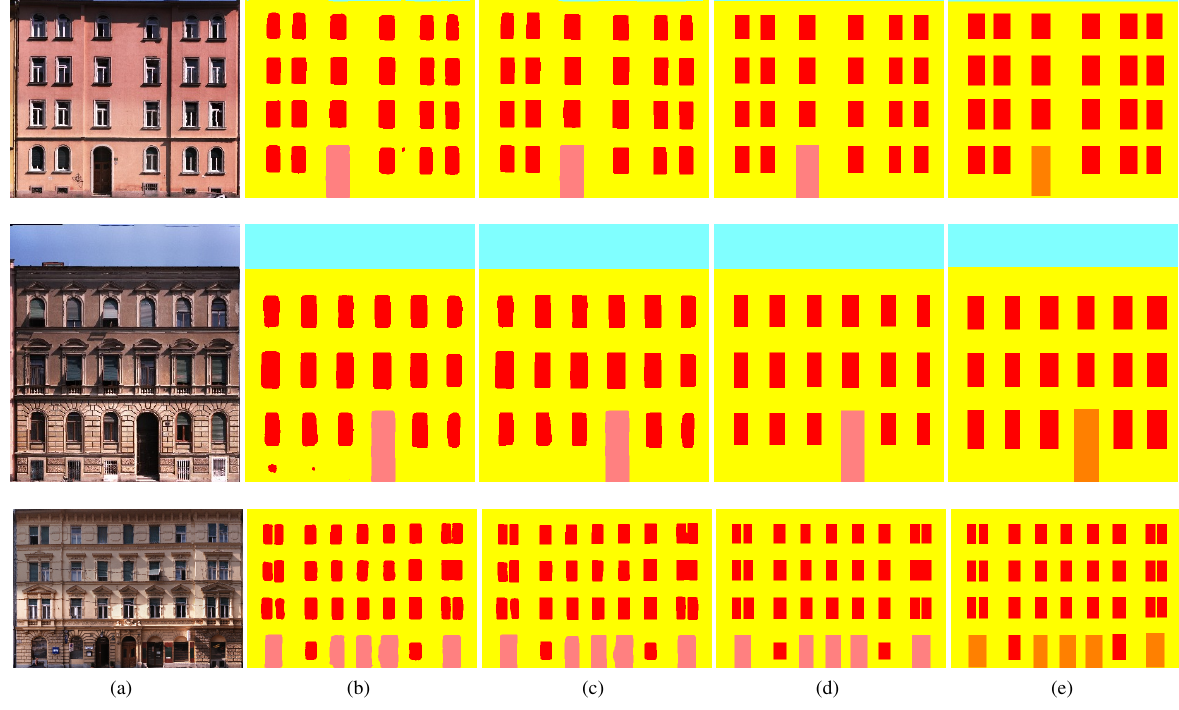
Figure 4. Qualitative results on the Graz dataset. The facade segments are homogeneous and nearly without noise. Column (a) input images, (b) results from Structured Random Forest with Regional Proposal Network, (c) results after 6 iterations of the optimization, (d) results after Rectangular Fitting and (e) ground truth. Object classes: